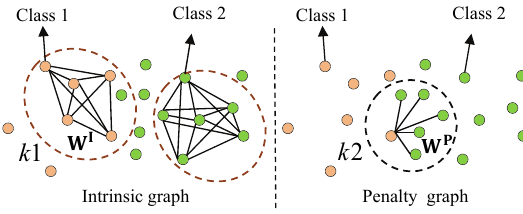
Figure 3. The adjacency graphs of graph